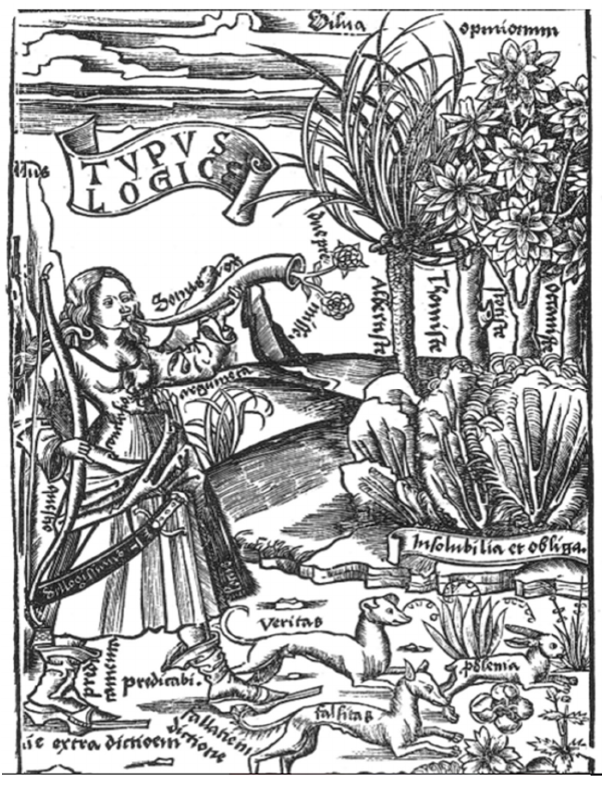
Figure 1. Typus logice